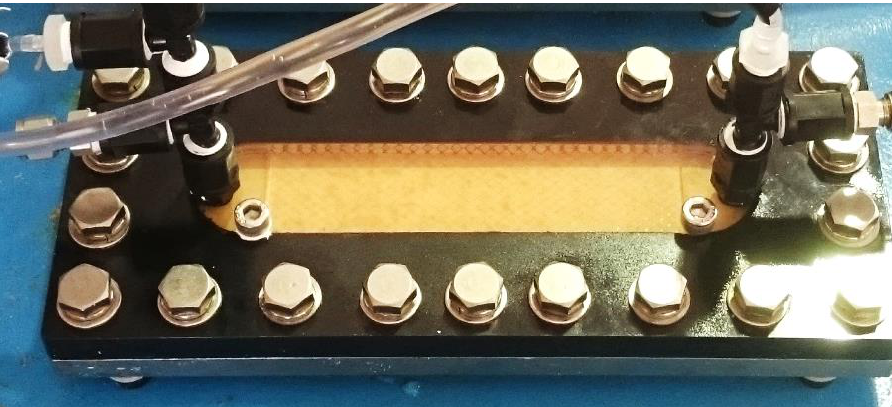
Figure 4. Appearance of the flat sheet membrane cell.